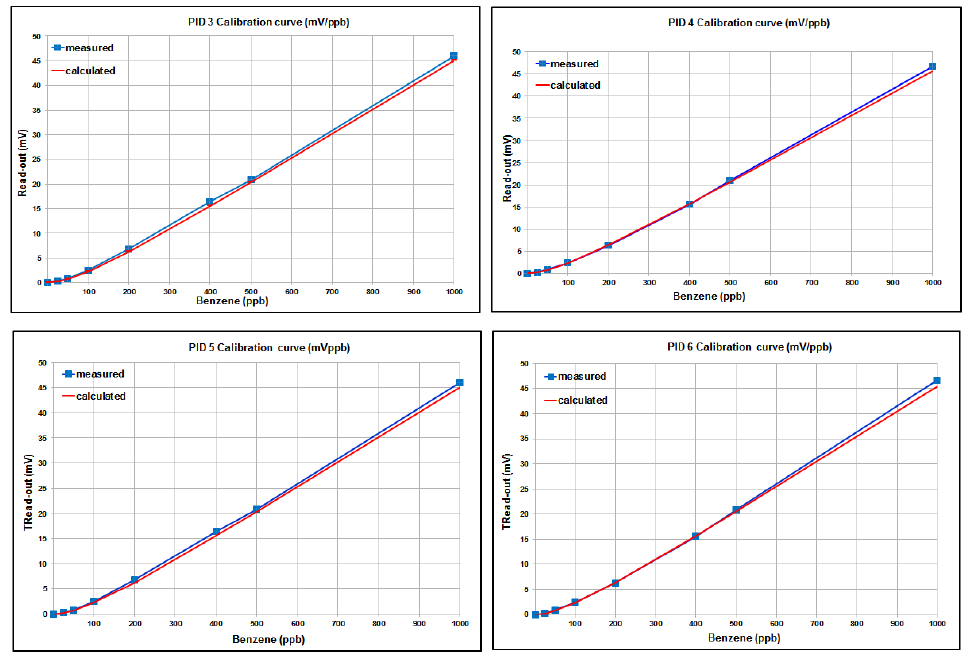
Figure 8. Calibration curves measured and calculated for the set of six PIDs.